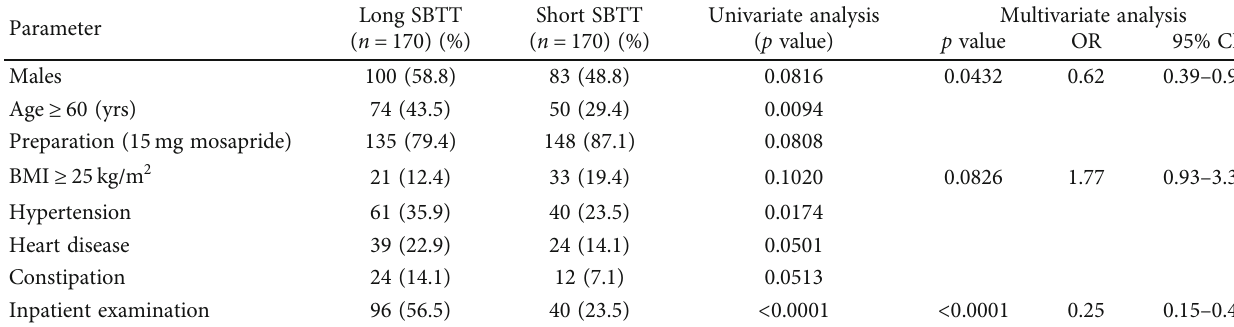
Table 4: Univariate and multivariate analyses of factors related to short SBTT.